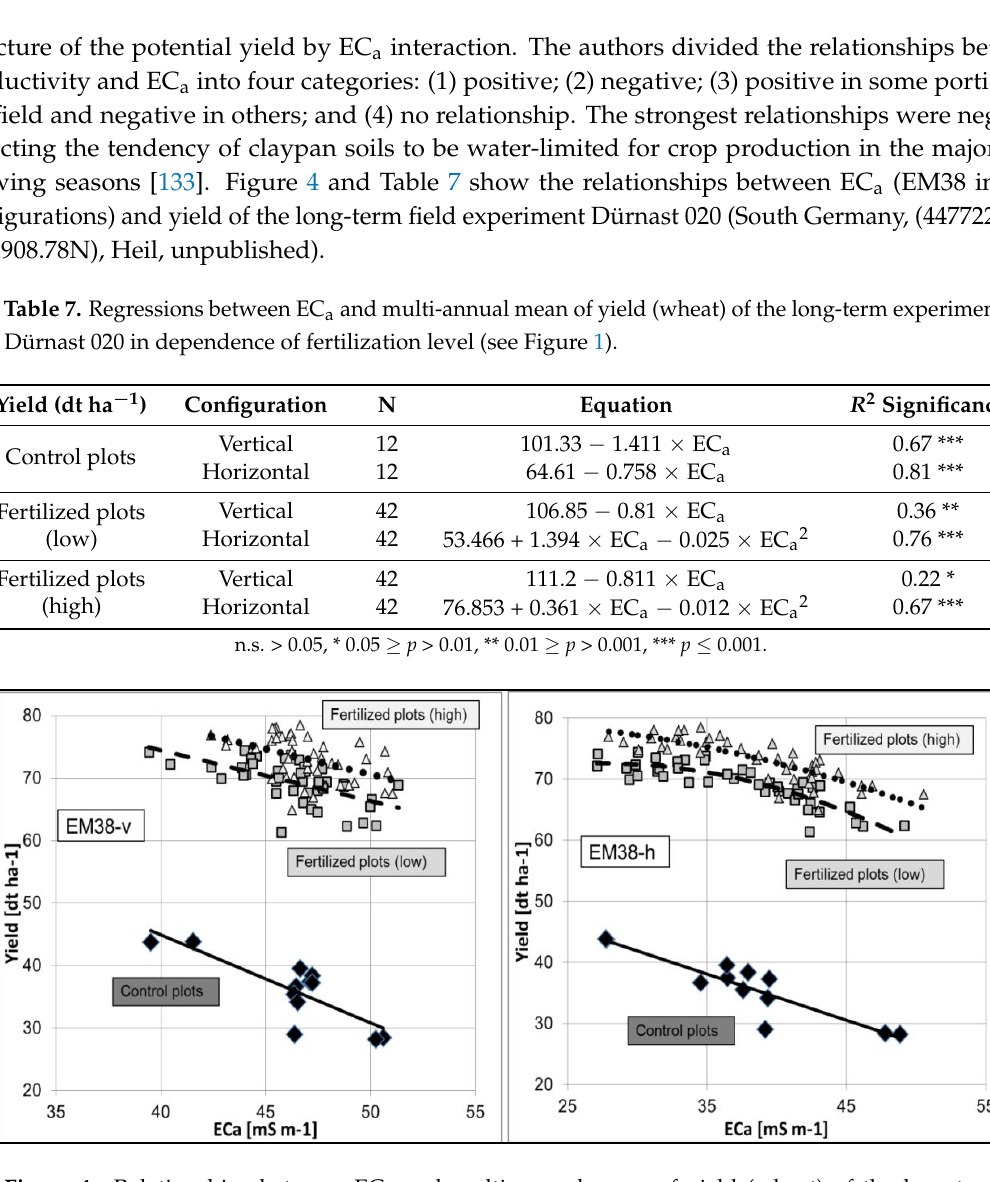
Figure 4. Relationships between EC a and multi-annual mean of yield (wheat) of the long-term experiment Dürnast 020 in dependence of fertilization level (control plots: no fertilizer, fertilized plots (low): 100–140 kg ha −1 N, fertilized plots (high): 150–180 kg ha −1 N).